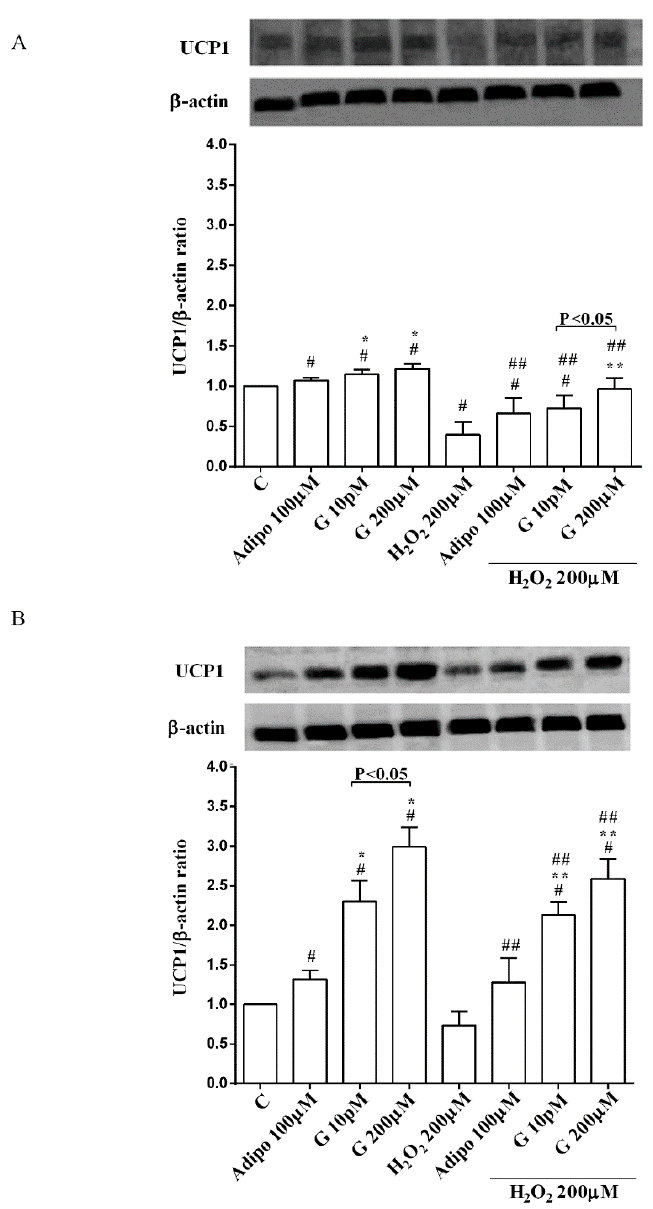
Figure 7. Effects of genistein on UCP1 activation in pre-adipocytes ( A ), and brown adipocytes ( B ), cultured in physiological and peroxidative conditions: Abbreviations are as in previous figures. Reported data are means ± SD of five independent experiments for each experimental protocol executed in adipocytes taken from each patient. Significance between groups: # p < 0.05 vs. control; * p < 0.05 vs. Adipo 100 µM; ## p < 0.05 vs. H 2 O 2 200 µM; ** p < 0.05 vs. Adipo100 µM + H 2 O 2 200 µM. Short square brackets indicate significance between groups ( p < 0.05).